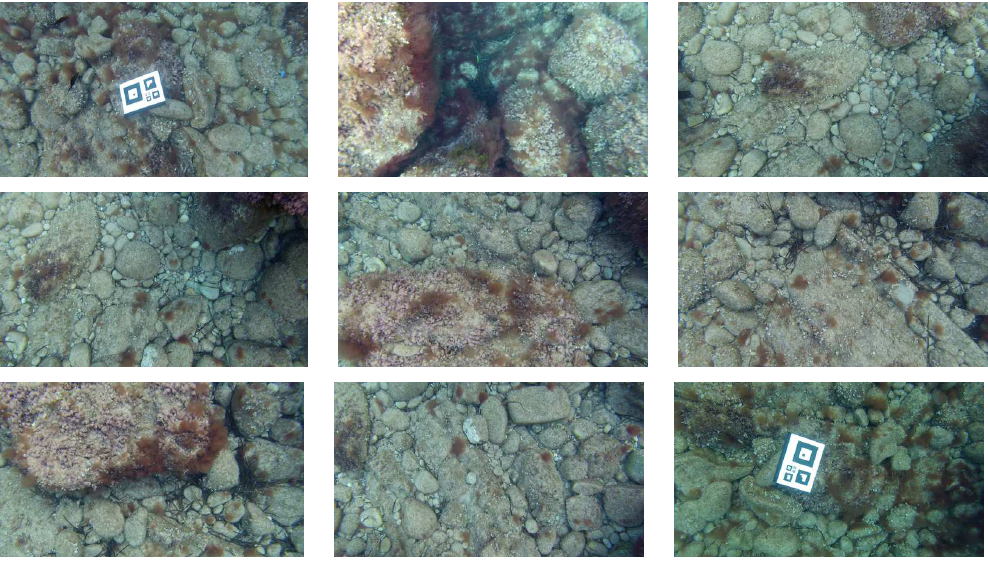
Figure 17. Some images gathered during the experiment in the sea, in Port de Valldemossa. The image on the first row-first column corresponds to the start of the trajectory, and the image on the third row-third column corresponds to the end. The trajectory was performed at a constant depth.